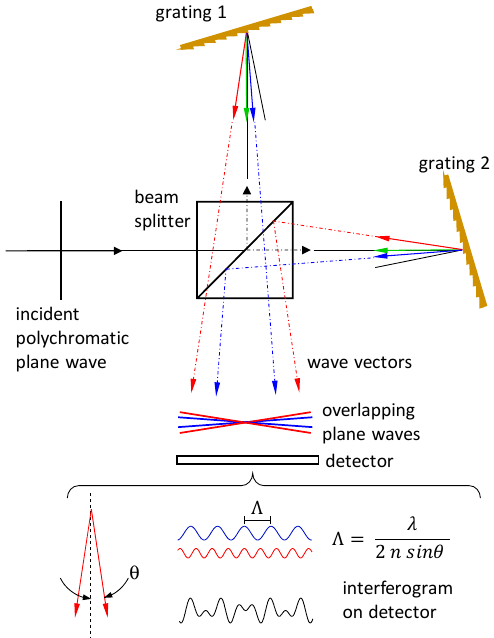
Figure 24. Illustration of the basic principle of spatial heterodyne spectroscopy (SHS).